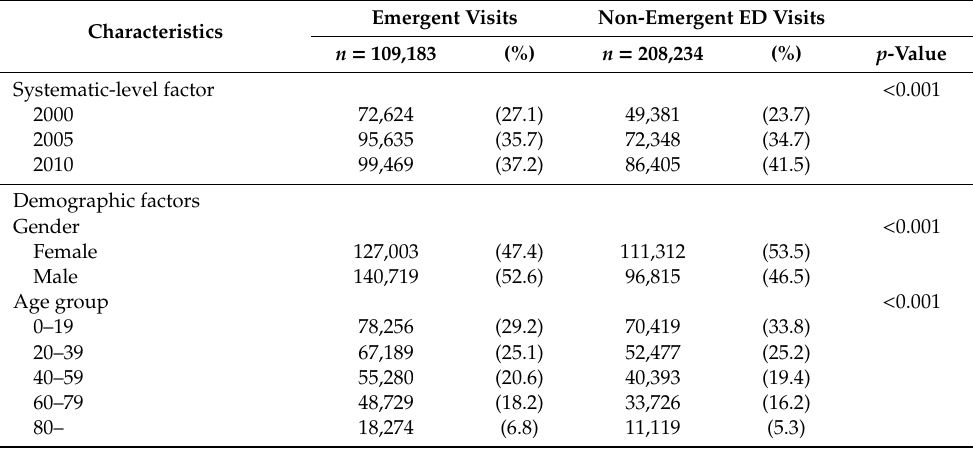
Table 1. Personal and ED visit characteristics by ED visit classification from three representative study cohorts (LHID2000, LHID2005, LHID2010) in Taiwan. ( n = 1,000,000 for each cohort; total ED visits, n = 475,862).